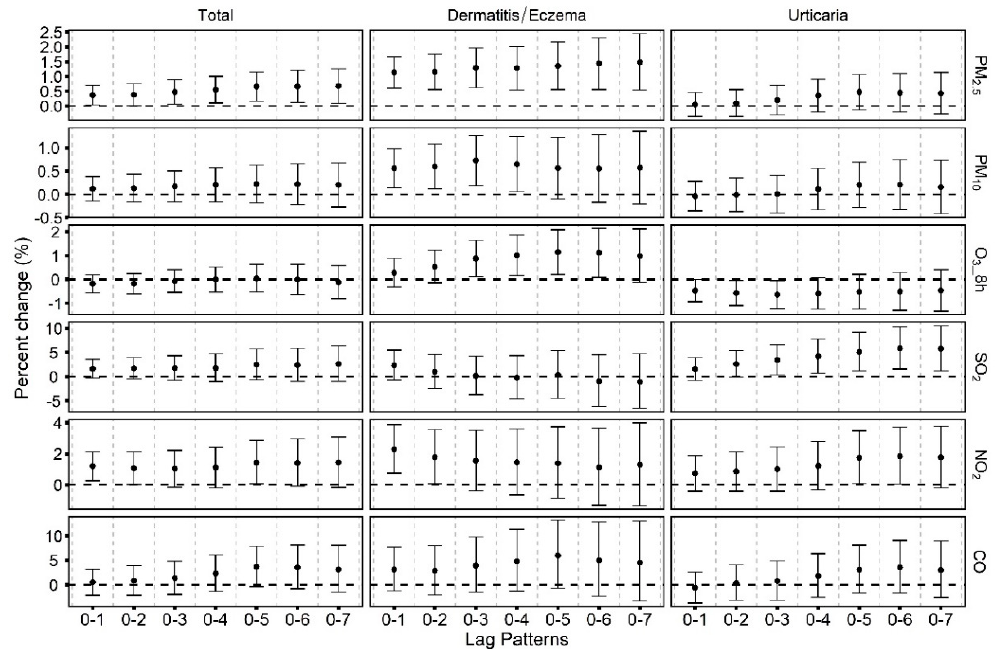
Figure 2. Overall percent changes and 95% confidence intervals (CIs) in daily emergency room visits for skin diseases per 10 µ g/m 3 increases in PM 2.5 , PM 10 , 8 h maximum O 3 , SO 2 , NO 2 and 1 mg/m 3 increase in CO with different time metrics (2014–2019).